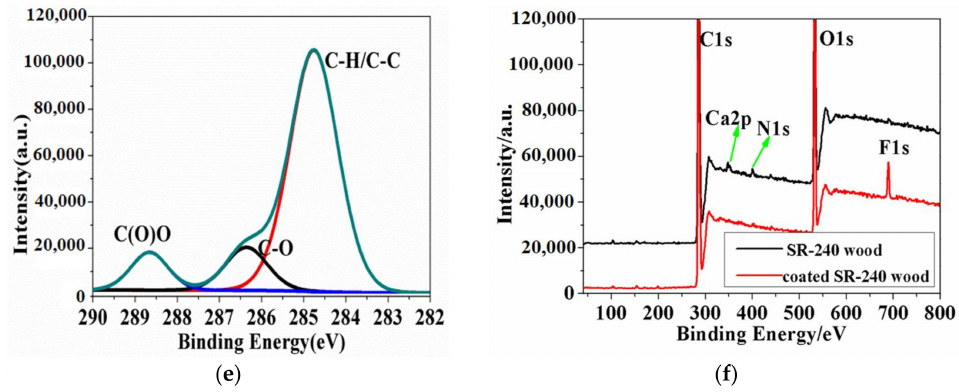
Figure 5. ( a ) The effect of the styrene (ST)/butyl acrylate (BA) mass ratio on water CAs; ( b ) The effect of the ST/BA mass ratio on the T g of as-prepared polymers. X-ray photoelectron spectroscopy (XPS results of ( c ) SR-240 wood; ( d ) coated SR-240 wood with 60 ◦ CAs and ( e ) coated SR-240 wood with 152 ◦ CAs (red line: C–C/C–H; black line: C–O; blue line: C(O)O; green line: envelope); ( f ) XPS survey for SR-240 wood and coated SR-240 wood with 152 ◦ CAs.